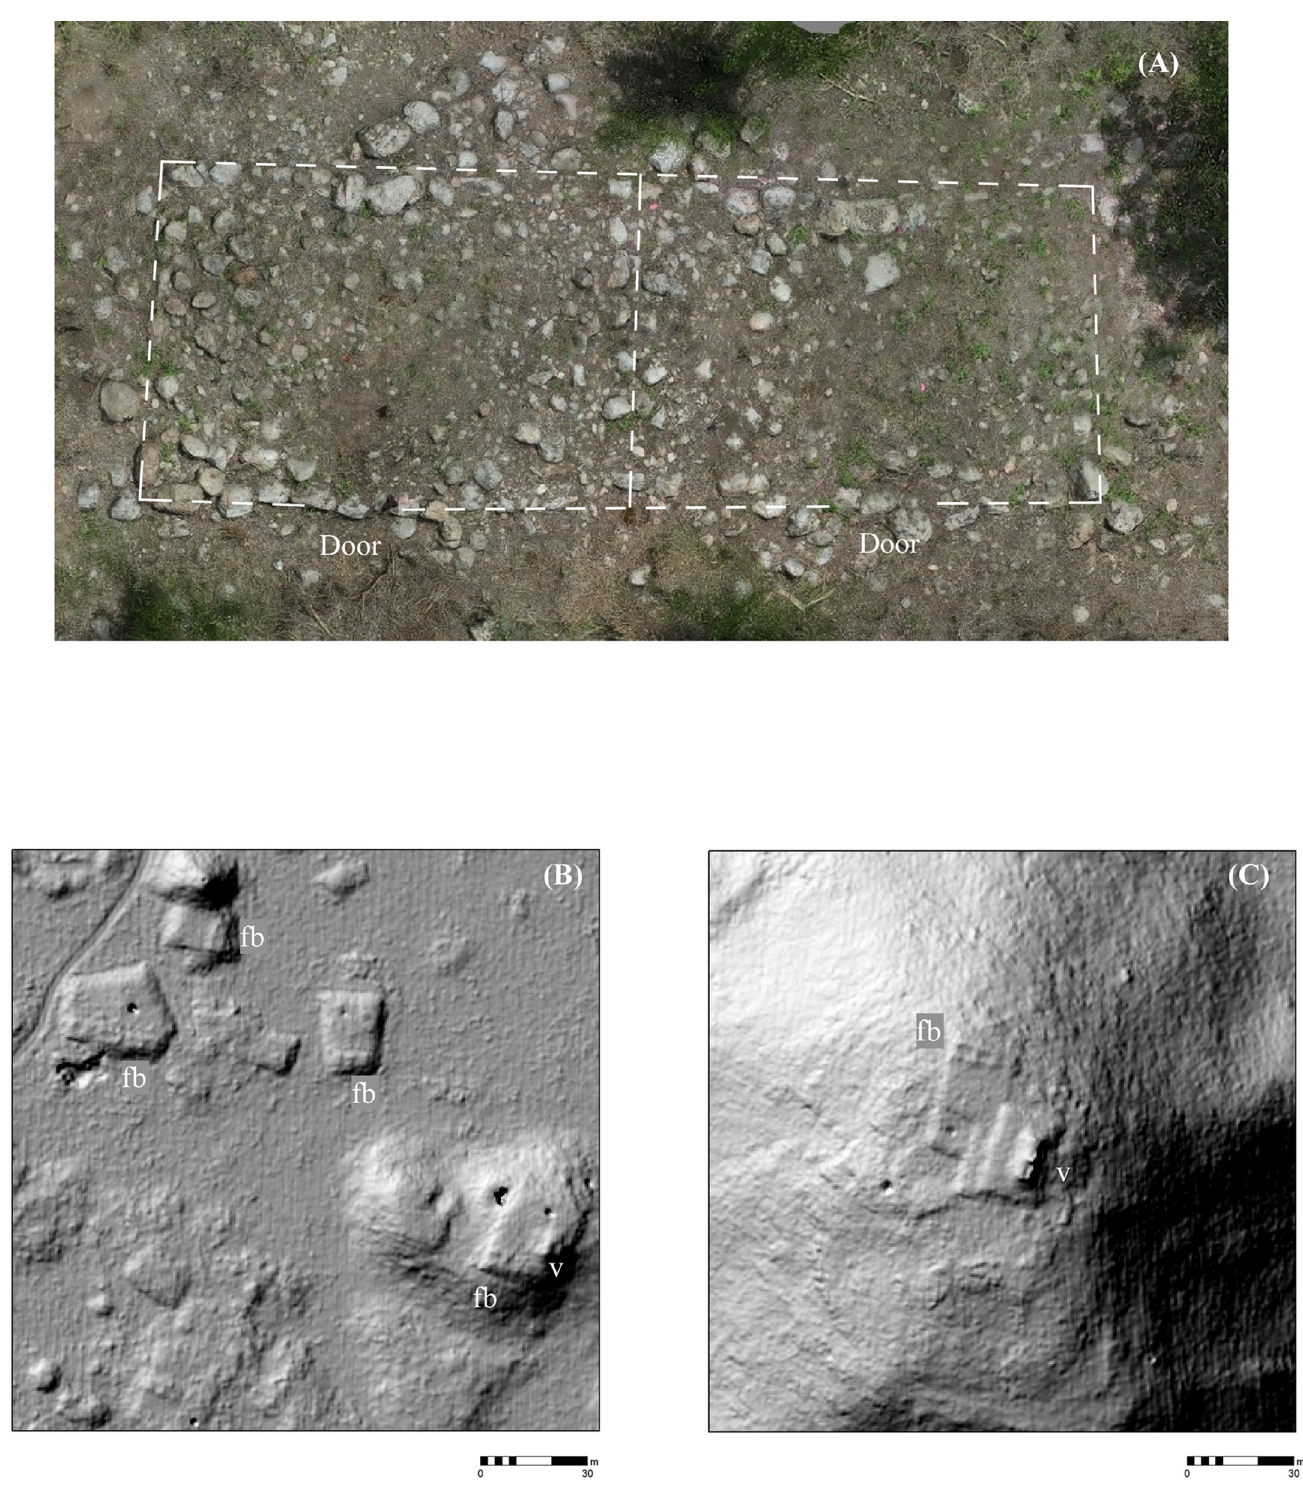
Fig 6. Frame braces of perishable housing. (A) An archaeological example cleared for mapping (not visible in the lidar). (B) examples from Acambalam II/III. (C) a particularly well-defined example from Kiuic, adjacent to a vaulted building (fb = frame brace, v = vaulted building).